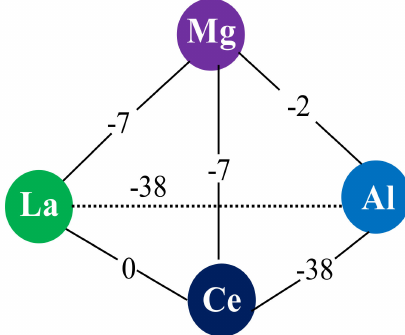
Figure 5. The values of ∆ H mix (KJ / mol) calculated by Miedma’s model for atomic pairs between major [ AB ] elements of Mg-RE sheet